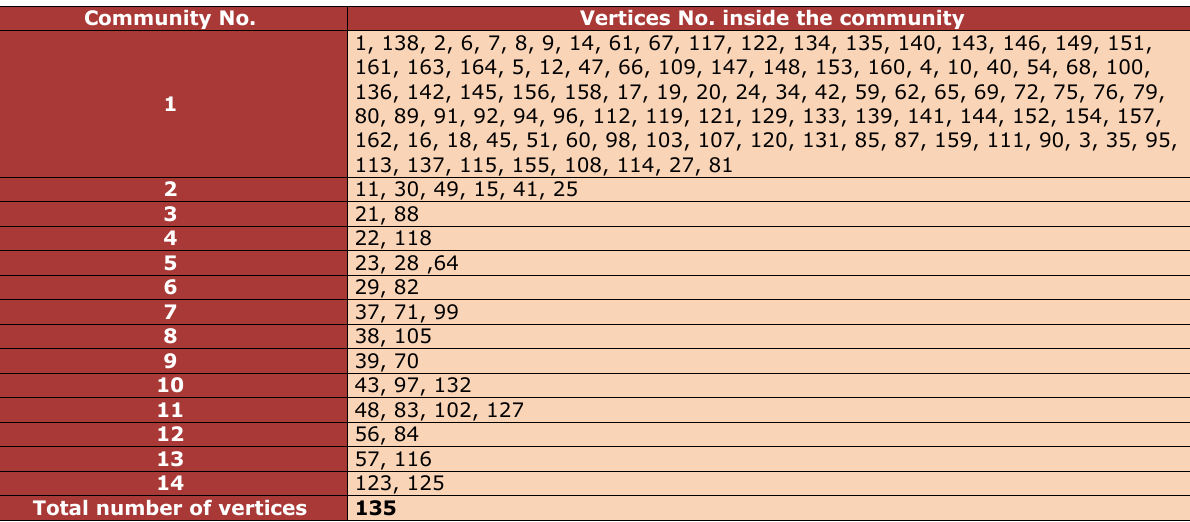
Table 3. The Community Structure Distribution by GN Algorithm with Threshold 0.6